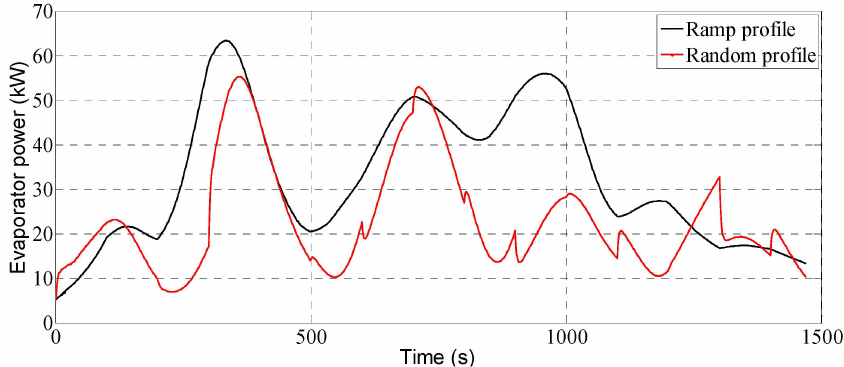
Figure 10. Evaporator power of the FV model.